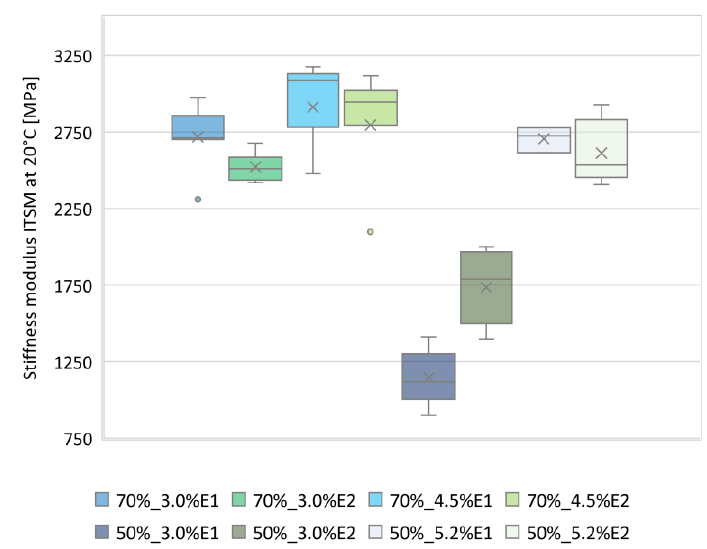
Figure 8. Box plot of ITSM values at 20 °C.